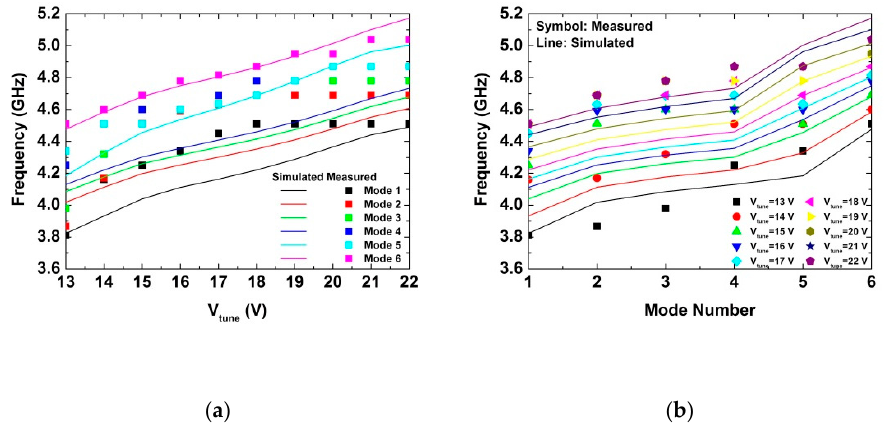
Figure 6. Simulated and measured frequency tuning range versus ( a ) varactor biases and ( b ) selection modes for the switched inductor VCO.